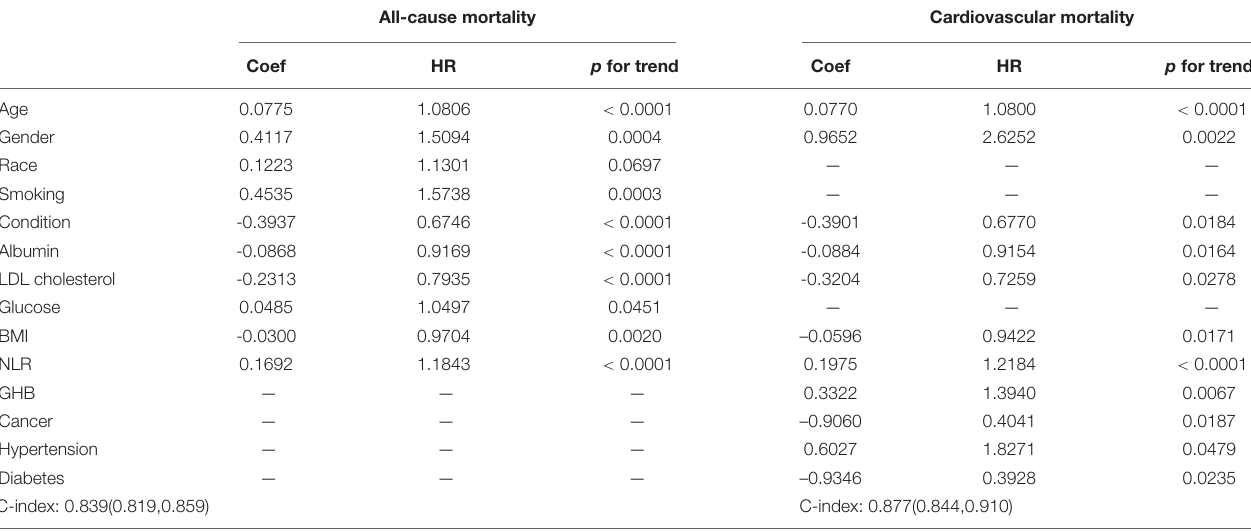
TABLE 3 | Parameters of Cox regression model in nomogram for all-cause and cardiovascular mortality. All-cause mortality Cardiovascular